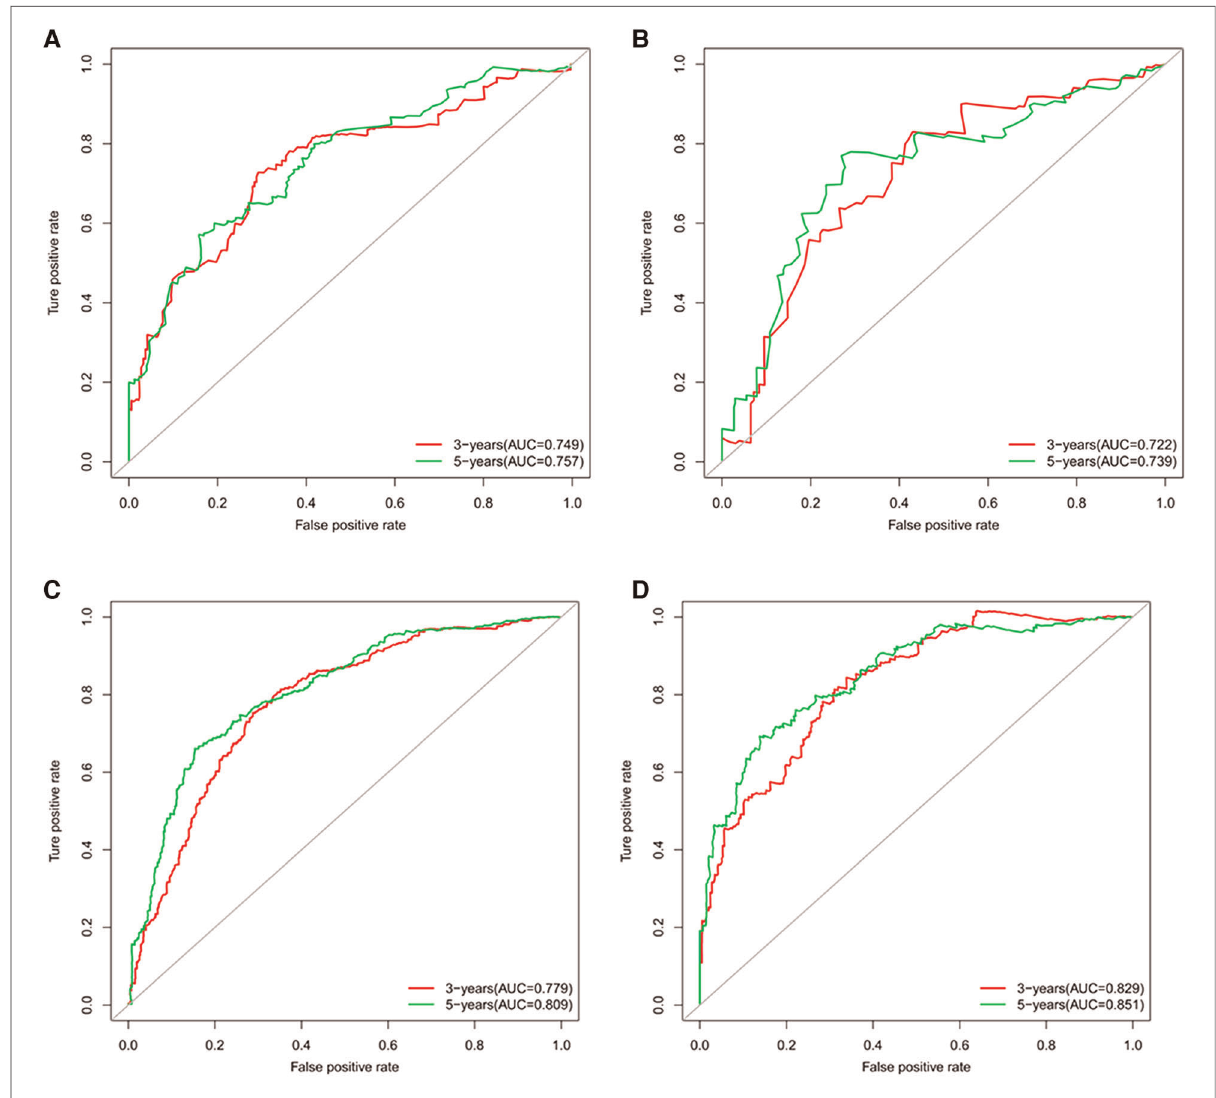
FIGURE 4 ( A ) Time-dependent receiver operating characteristic (t-ROC) curves of internal validation to predict OS of chemotherapy cycles <9, ( B ) Time- dependent receiver operating characteristic (t-ROC) curves of external validation to predict OS of chemotherapy cycles <9, ( C ) Time-dependent receiver operating characteristic (t-ROC) curves of internal validation to predict OS of chemotherapy cycles ≥ 9 and ( D ) Time-dependent receiver operating characteristic (t-ROC) curves of external validation to predict OS of chemotherapy cycles ≥